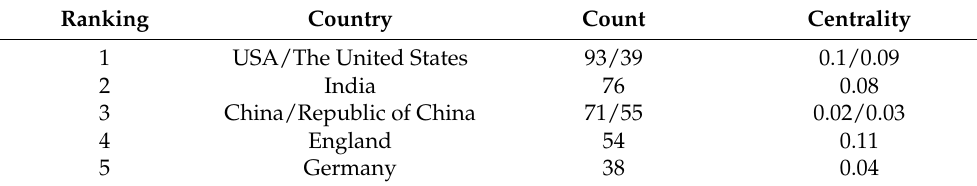
Figure 2. The map distribution of countries (The yellow points represent contributed countries). Table 1. Top 5 countries according to the number of publications.